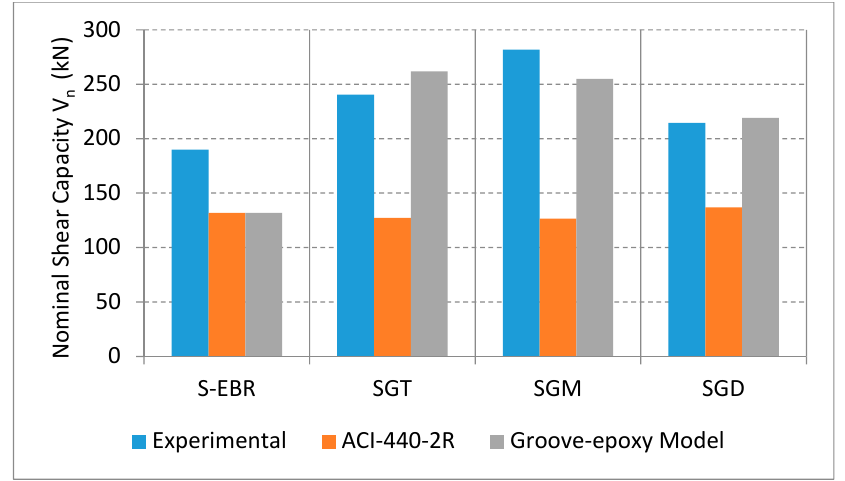
Figure 16. Comparison of measured and predicted shear capacity for RC beams strengthened with CFRP sheets on groove-epoxy.